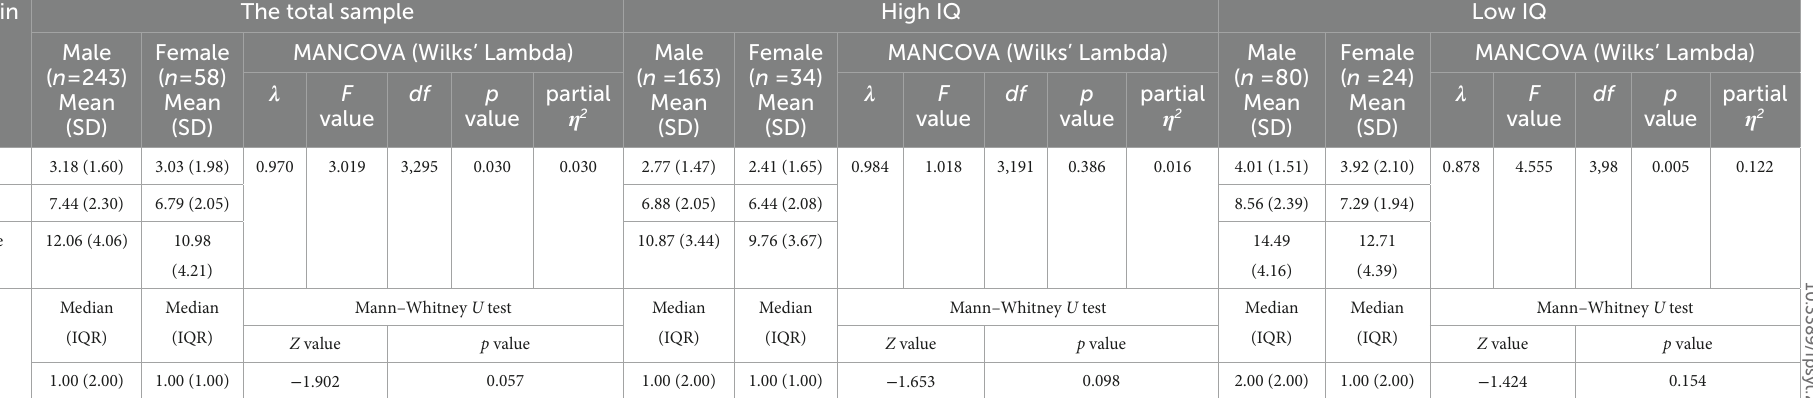
TABLE 7 Sex differences among children with ASD in the domain scores of ADOS.